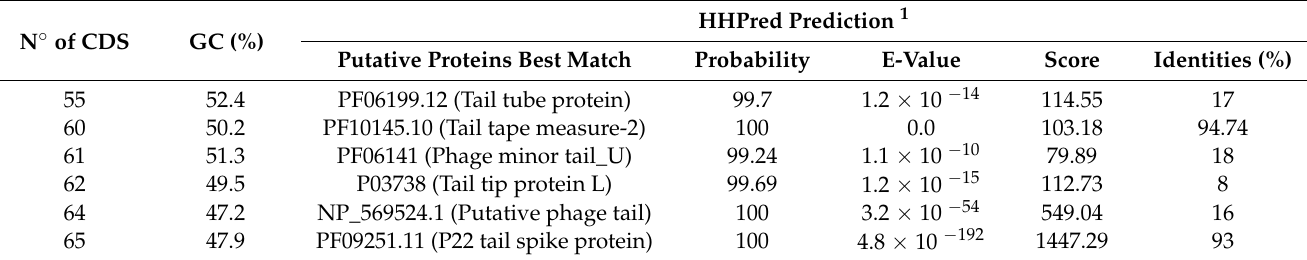
Table 2. Structural proteome analysis of putative receptor-binding proteins (RBPs) of the STGO- 35-1